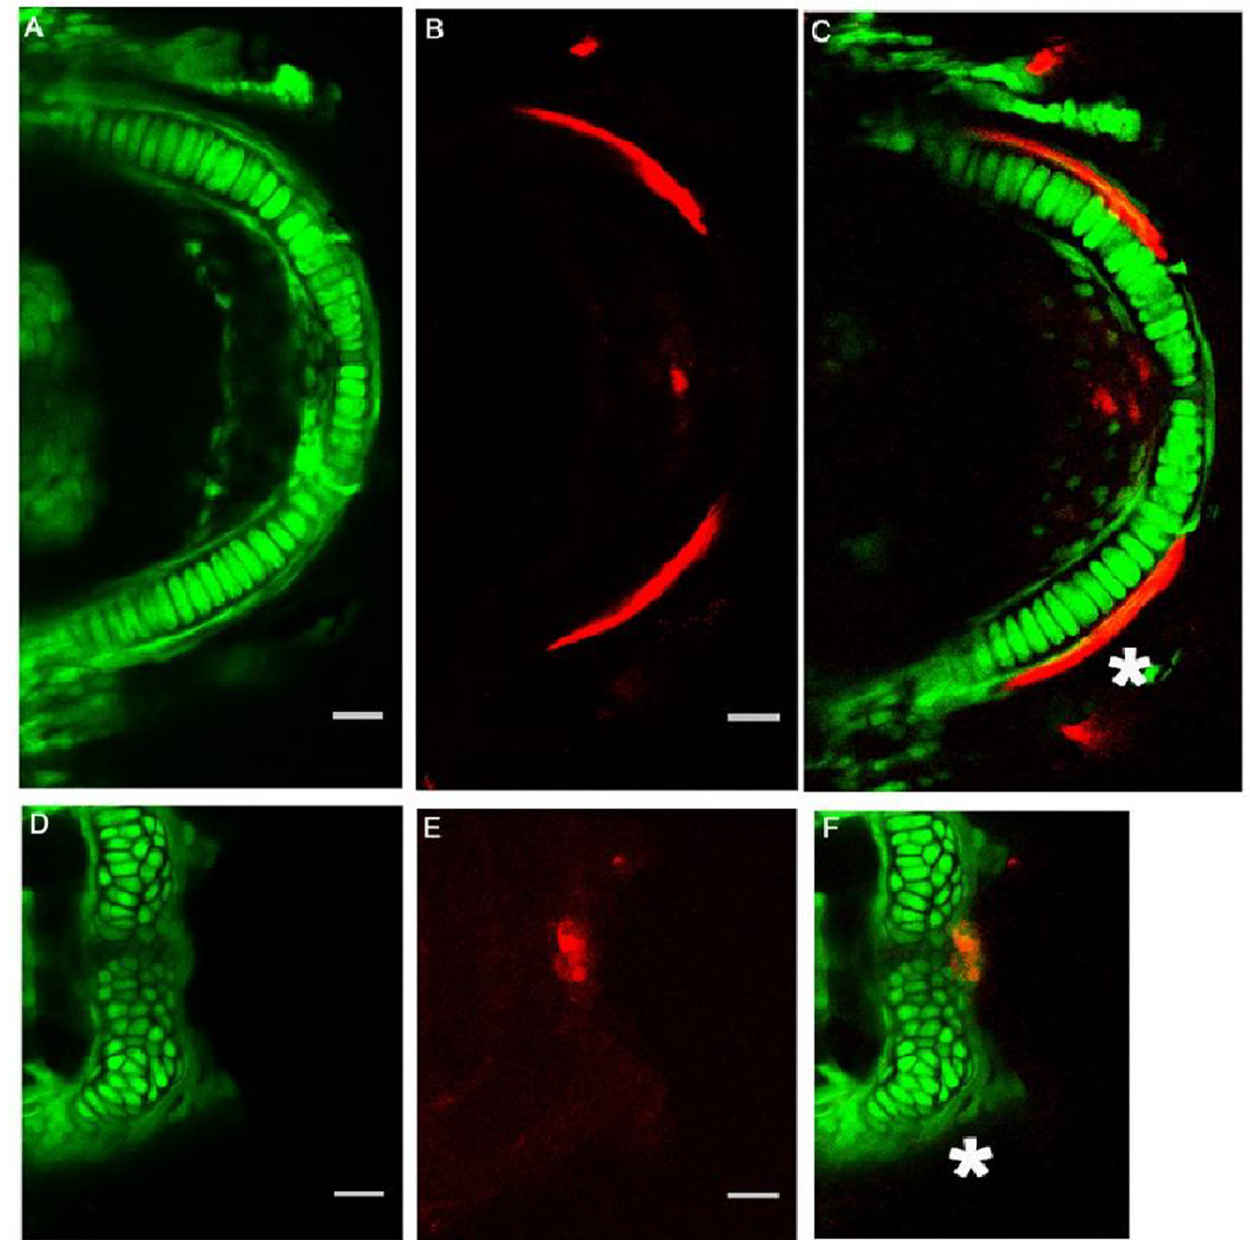
Figure 3. Col11a1a expression was required for Meckel’s chondrocyte organization, extension, and mineralization. The Fli1a:EGFP expressing cells in the Meckel’s cartilage formed an organized stack of chondrocytes that allowed the arch-like structure of Meckel’s cartilage to form ( A ) Alizarin Red staining indicated that the perichondraal cells produced a mineralized structure immediately adjacent to the Meckel’s cartilage (( C ), white asterisk) and initiated mineralization at the central distal tip ( B , C ). In contrast, the cells of the morphant were not flattened, nor were they organized into a stack of cells as observed in the control (( D ) compared to ( A )). Lateral mineralization of the bilateral rods in the morphant was not detected (( F ), white asterisk). Mineralization was detected by Alizarin Red staining at the central distal tip ( F ). Scale bars 20 µ